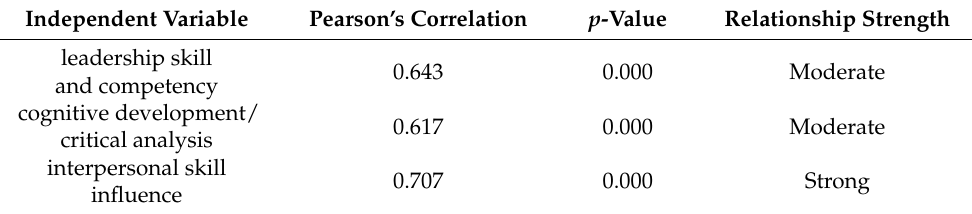
Table 4. Pearson’s correlation coefficients of independents variables and innovative behaviour.